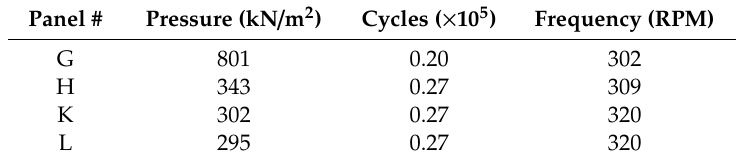
Table 3. Conditions of the slamming tests to modified panels with viscoelastic